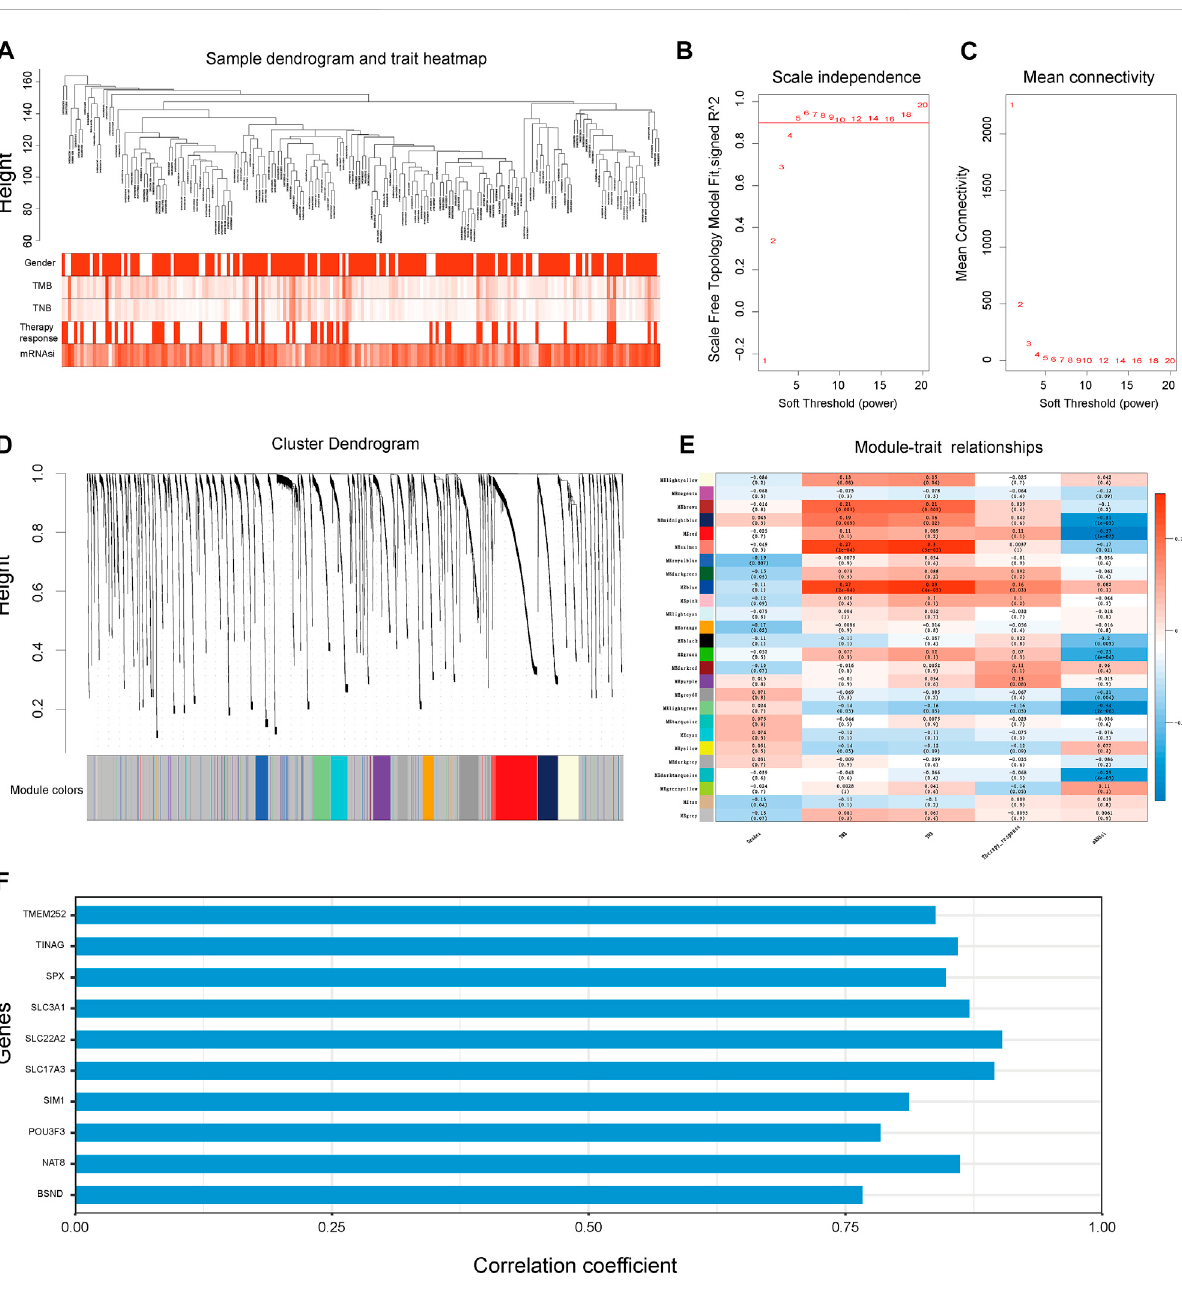
FIGURE 2 WGCNA analysis to identify the genes module correlated with cancer TNB and mRNAsi for TSIRS construction. (A) Clustering dendrogram of samples. (B) Scale-free index for different soft-thresholds. (C) Mean connectivity for different soft-thresholds. (D) Clustering dendrogram